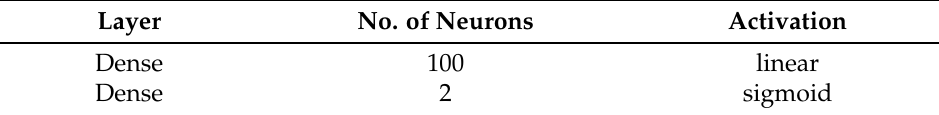
Table 2. Classifier and discriminator’s